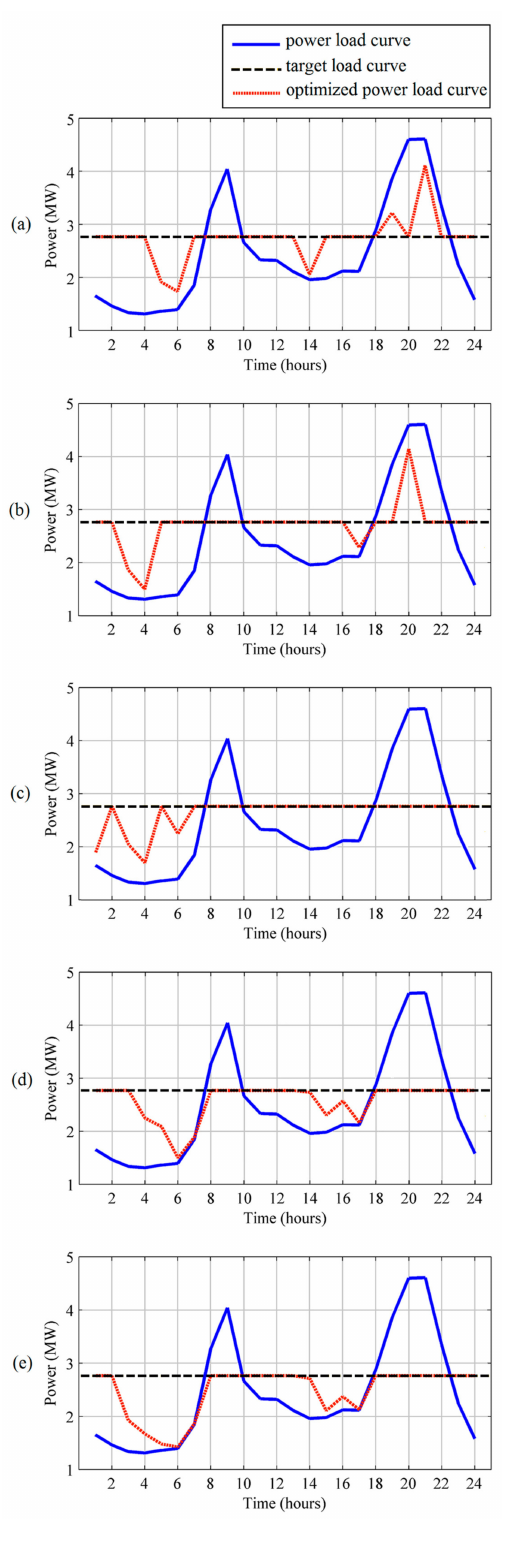
Figure 8. Optimized power load curves with 60% TLC pct and SOC i,ave of ( a ) 40%, ( b ) 50%, ( c ) 60%, ( d ) 70% and ( e )